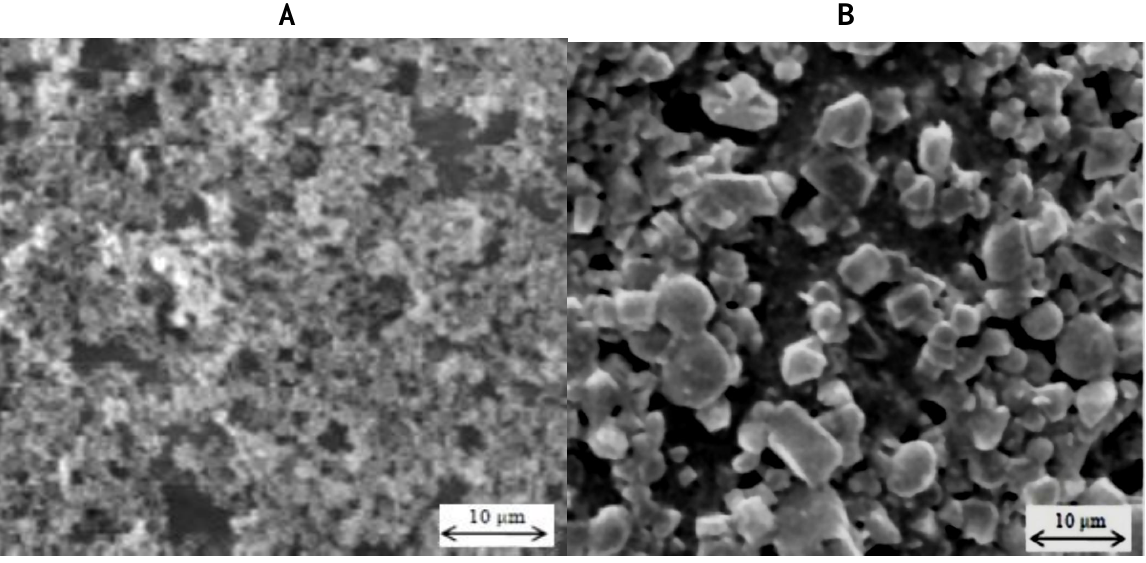
Fig. 3. SEM images of (A) MNPs, (B) Si-Im-HSO